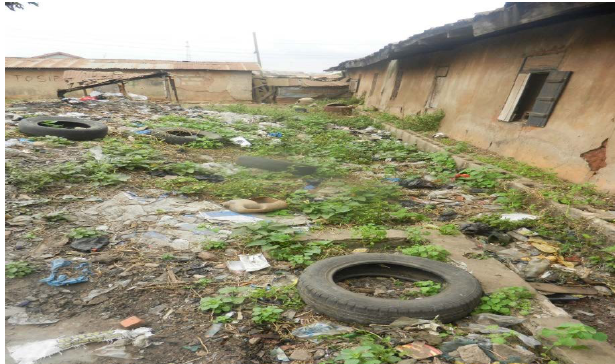
Figure 2. Open Dumping at the backyard of a residential compound at Owode LGA.